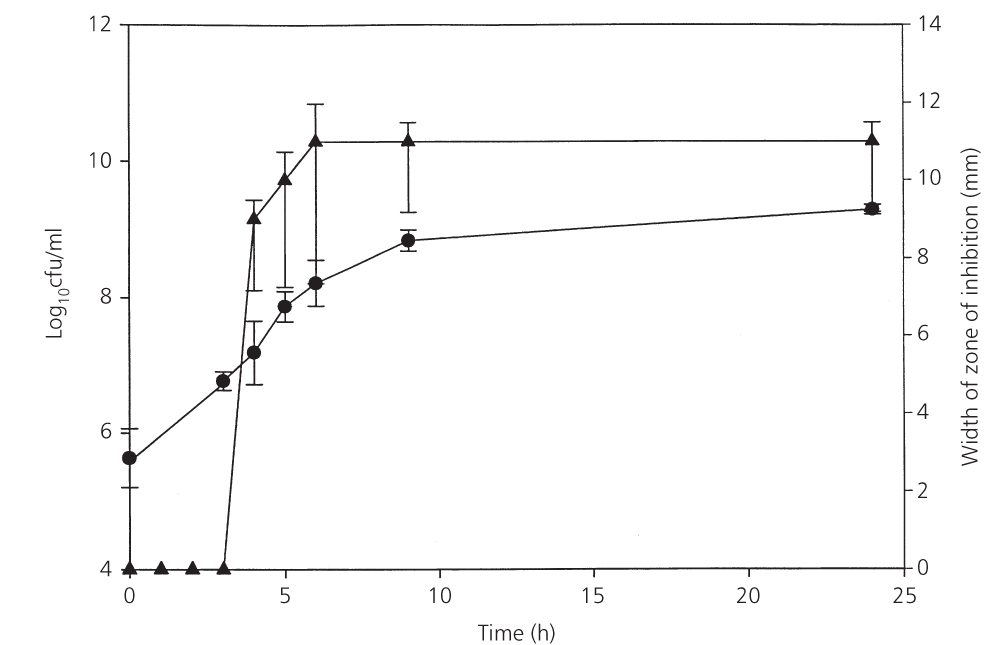
Figure 1 Kinetics of inhibitor production over time. Results represent the means and standard deviations of three independent experiments. The concentration of E. faecium strain 62-6 ( l ) was determined by plate count on BA. The inhibitory activity against indicator strain 4-1 ( s ) was determined using the well diffusion assay. The width of the zone of inhibition was obtained by subtracting the 5 mm diameter of the well from the diameter of the zone of